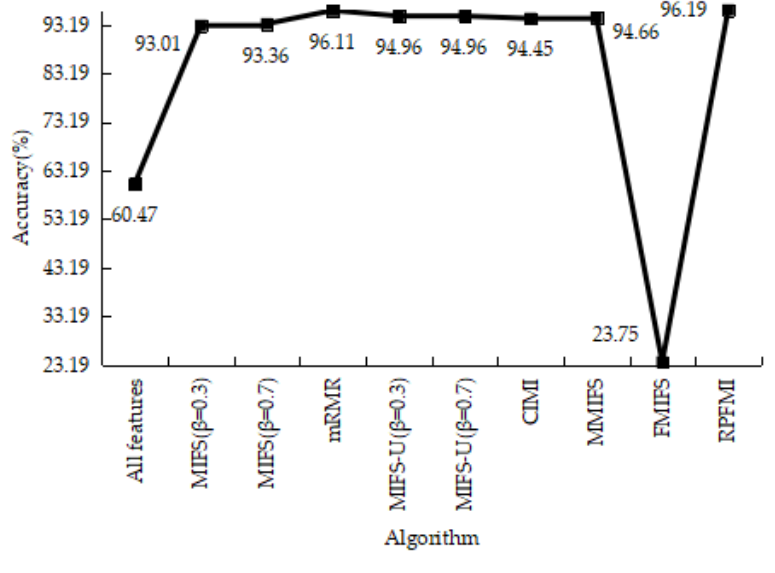
Figure 5. Accuracy on the U2R test data. Table 8. Confusion matrices in different models using the U2R test data.